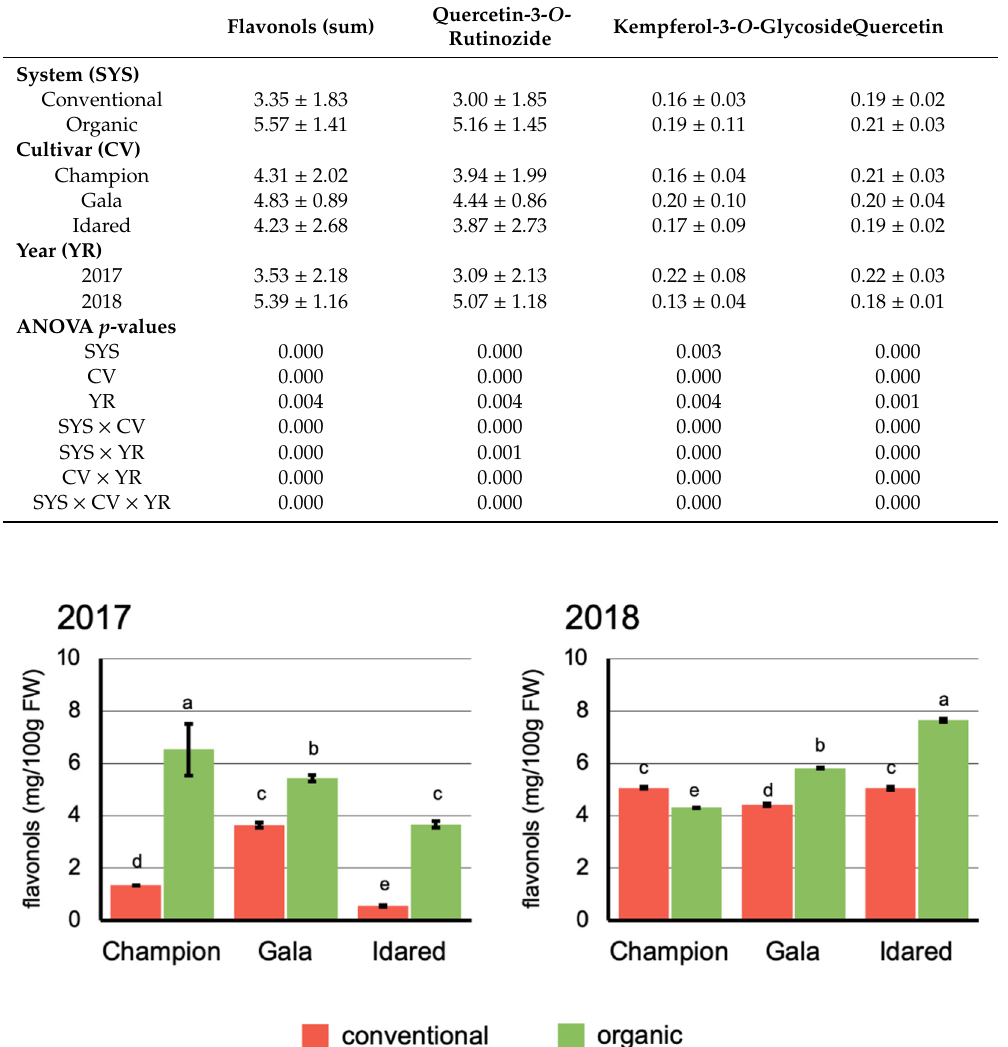
Table 3. The main e ff ect of (and interaction between) the production system (conventional and organic), cultivar (Champion, Gala, Idared) and harvest year (2017, 2018) on the concentrations (mean ± SD) of flavonols (mg / 100g f.w.) in apple fruit.